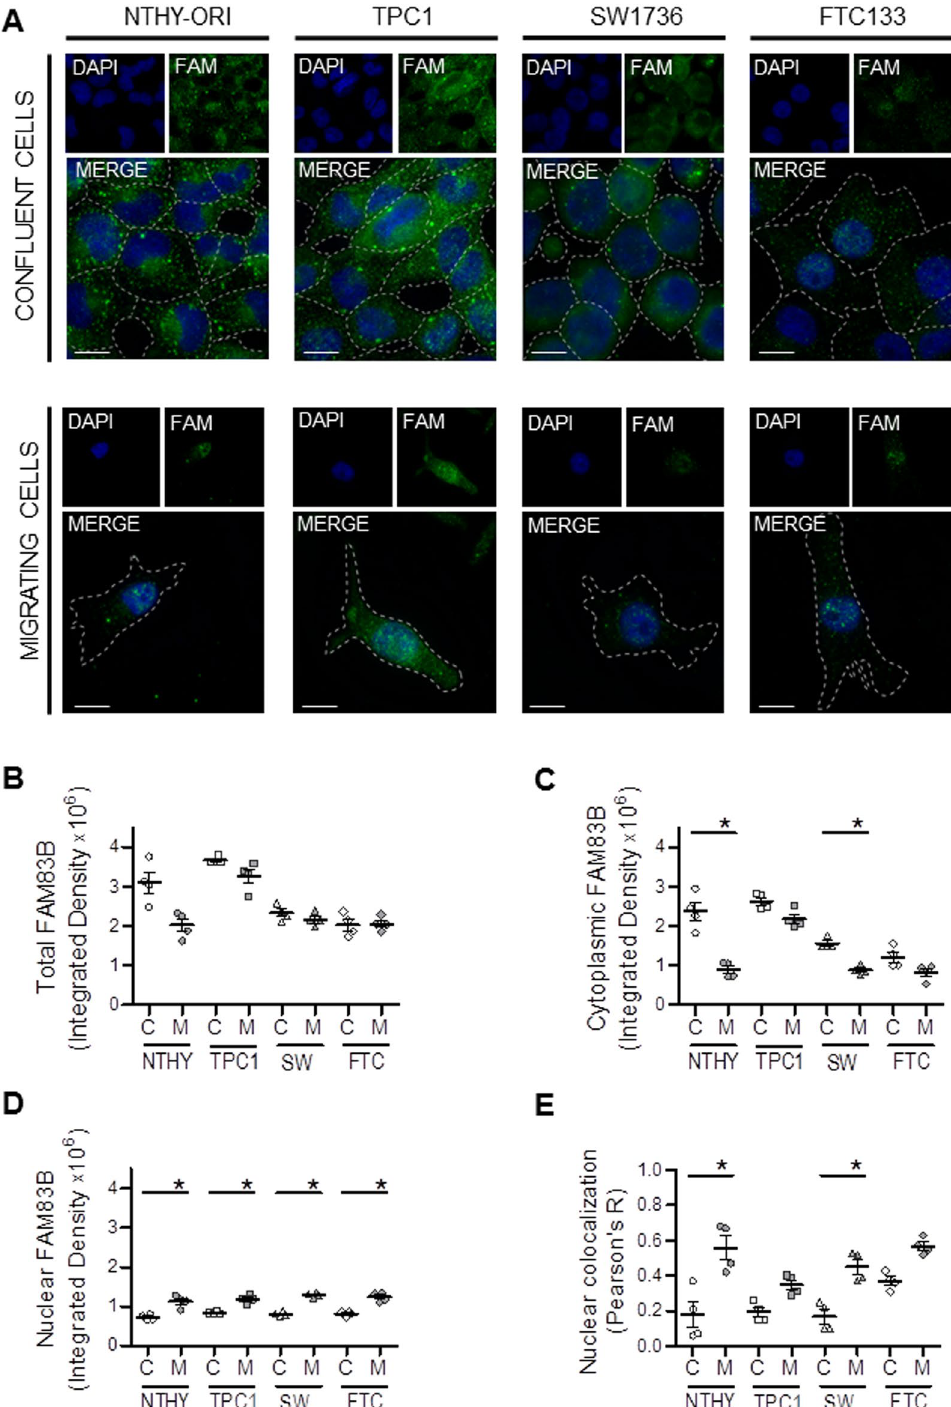
Figure 4. FAM83B subcellular localization significantly varies during cell migration. ( A ) Representative images of immunofluorescence experiments showing confluent and migrating cell lines. Dashed lines highlight cell morphology as determined by WGA staining (see Supplementary Fig. 3). Scalebars 10 µm. Four experiments were done for each cell line. The total number of cells analyzed was 110 for NTHY-ORI 3-1 (57 confluent and 53 migrating), 136 for TPC1 (66 migrating and 70 confluent), 135 for SW1736 (64 confluent and 71 migrating), 97 for FTC133 (56 confluent and 41 migrating). Total ( B ), Cytoplasmic ( C ) and nuclear ( D ) FAM83B levels quantified as Raw Integrated Density in the same experiments as in ( A ). ( E ) Nuclear co-localization with DAPI, with Pearson’s R coefficient. Statistical analysis: ( B–E ) Kruskal–Wallis test followed by Dunn’s Multiple Comparison